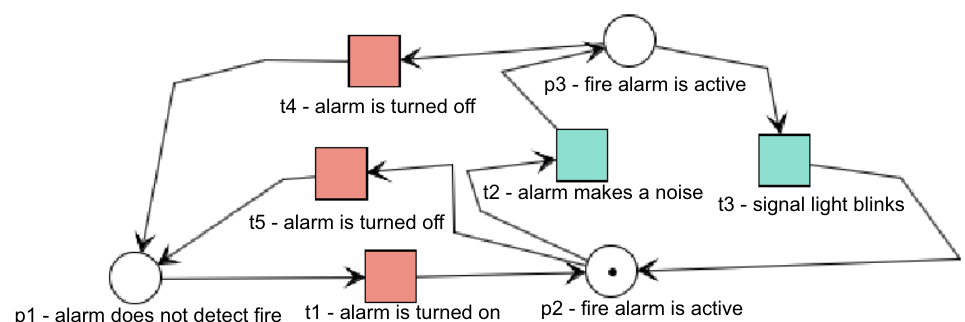
Figure 9. Petri Net for fire alarm ( t 1 is